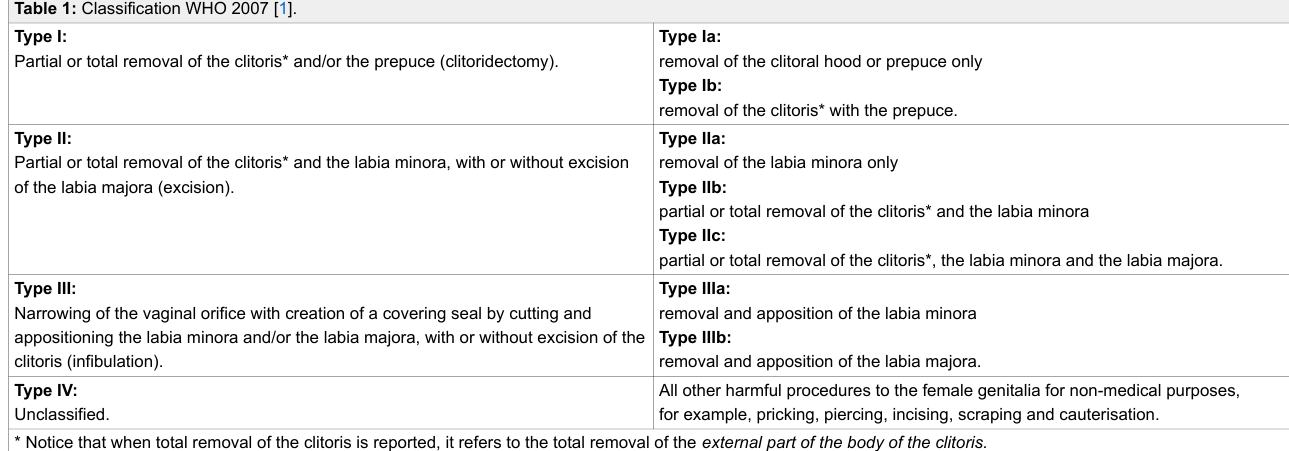
Table 1: Classification WHO 2007